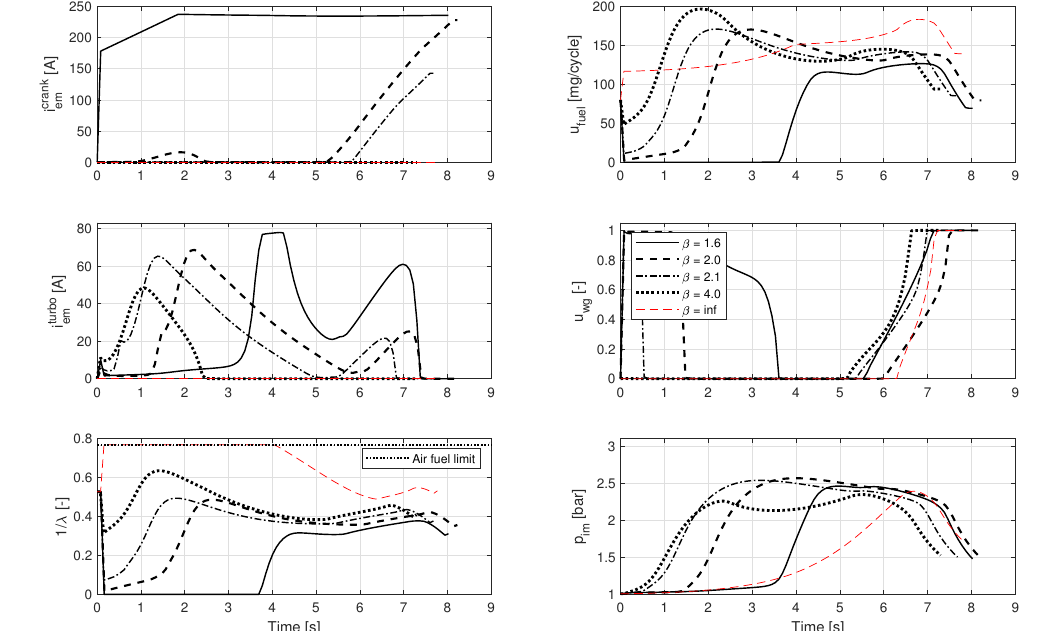
Figure 12. Controls, fuel-air ratio and intake manifold pressure during the acceleration when the engine is supported by both E-crank and